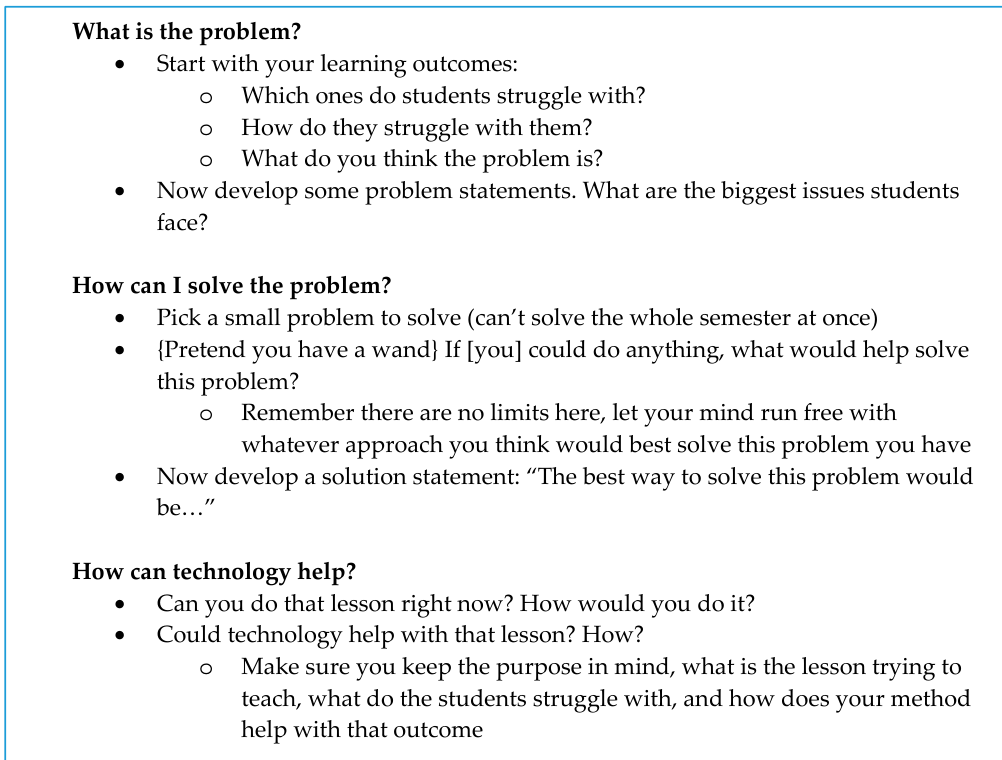
Figure 4. Pedagogy Before Technology worksheet for educators and educational designers. .